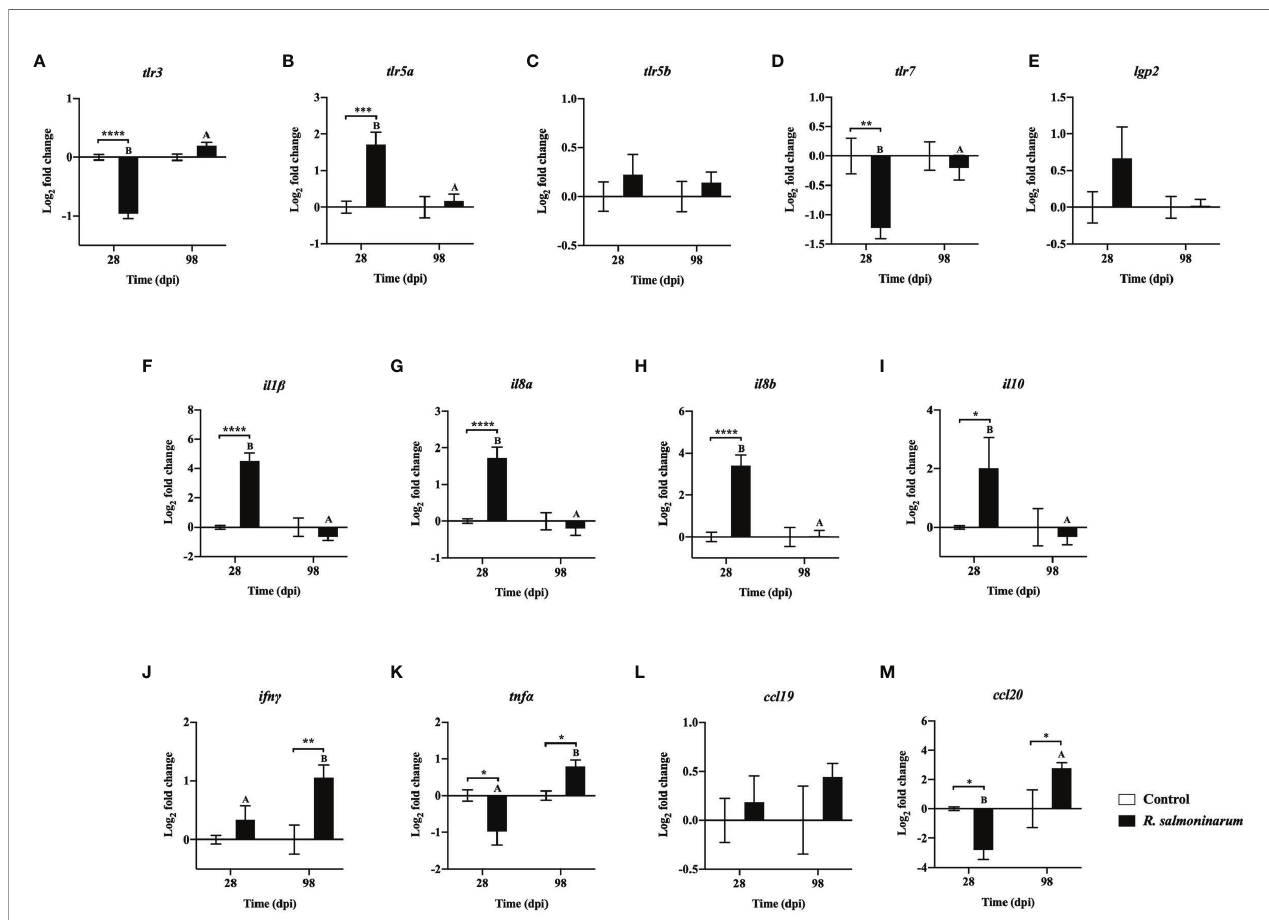
FIGURE 4 | Expression of transcripts related to pattern recognition (A-E) and cytokines (F-M) in lump fi sh head kidney in response to R. salmoninarum infection at 28 and 98 days post infection (dpi). Transcript expression levels in head kidney from control (PBS-mock infected group) and infected [high dose (1×10 9 cells/dose) of R. salmoninarum ] lump fi sh at 28 and 98 dpi were analyzed using qPCR. Relative expression was calculated using the 2 − DD Ct method and log2 transformed; etif3d and pabpc1b were the endogenous control genes. A two-way ANOVA test, followed by the Sidak multiple comparisons post hoc test was used to identify signi fi cant differences between treatments (control and infected groups) at a single time point, and for a given treatment at different time points (28 and 98 dpi). Asterisks (*) represent signi fi cant differences between treatments at each time-point (* p < 0.05, ** p < 0.01, *** p < 0.001, **** p < 0.0001). Different letters represent signi fi cant differences between control (lower case) and infected (upper case) groups at 28 compared to 98 dpi. Each value is the mean ± S.E.M ( n =